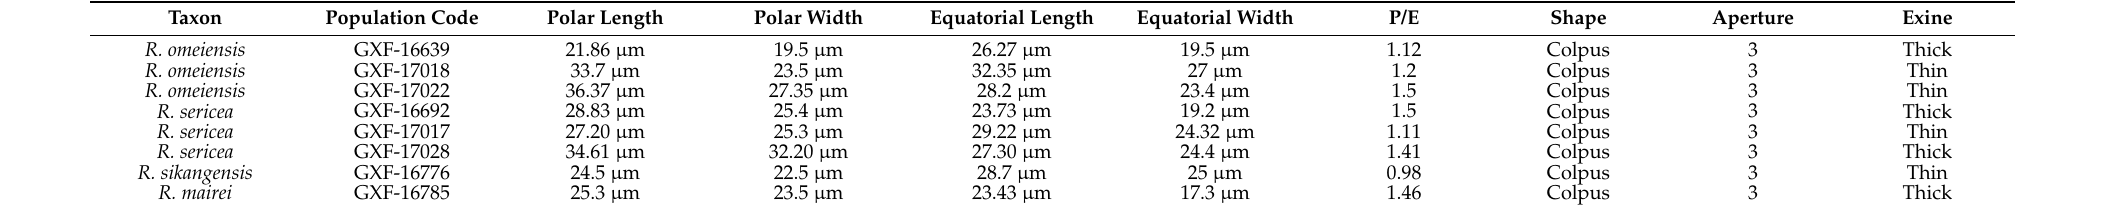
Table 4. Mean values of quantitative characters of different populations of R. sericea complex species.